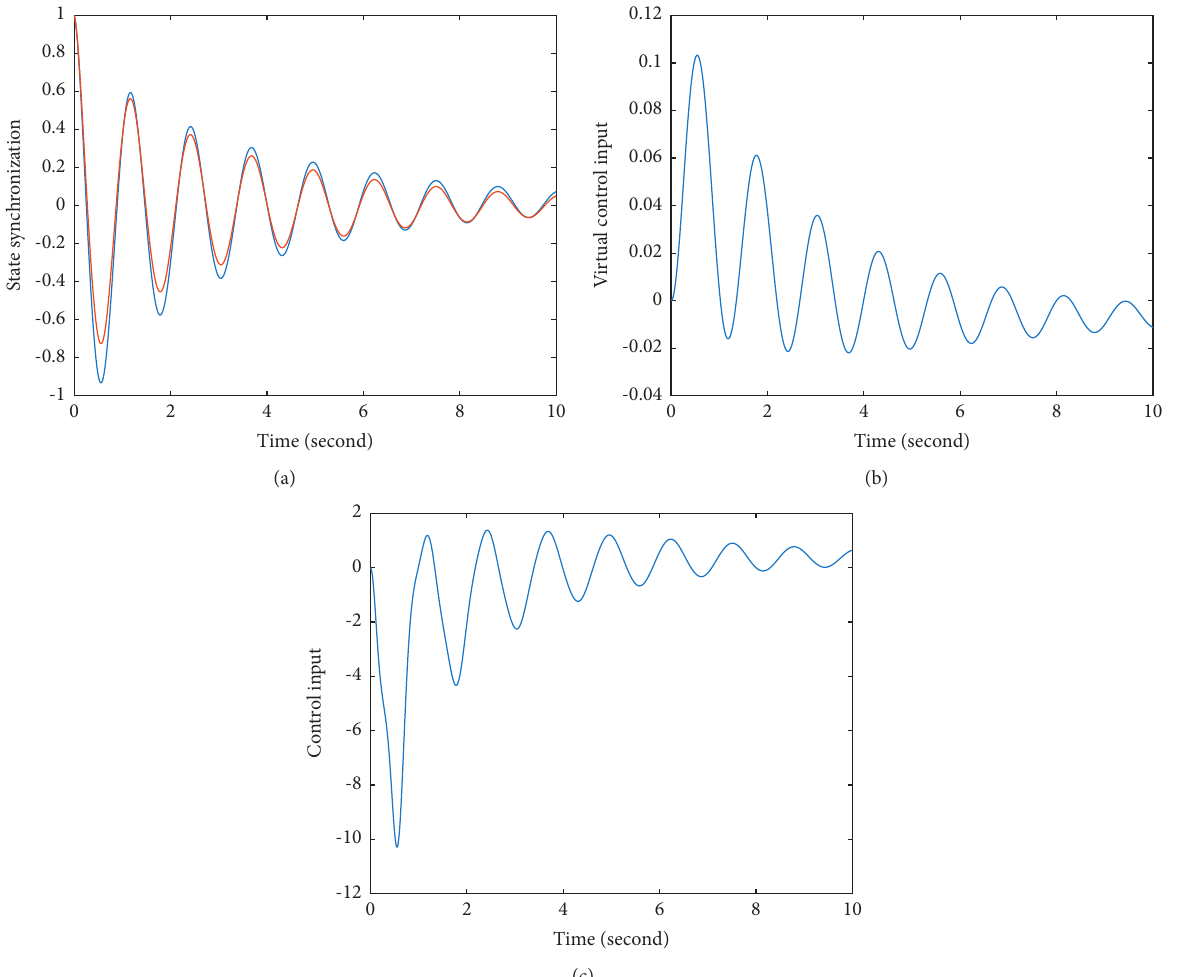
Figure 2: Simulation results: (a) state synchronization; (b) virtual control input; (c) control